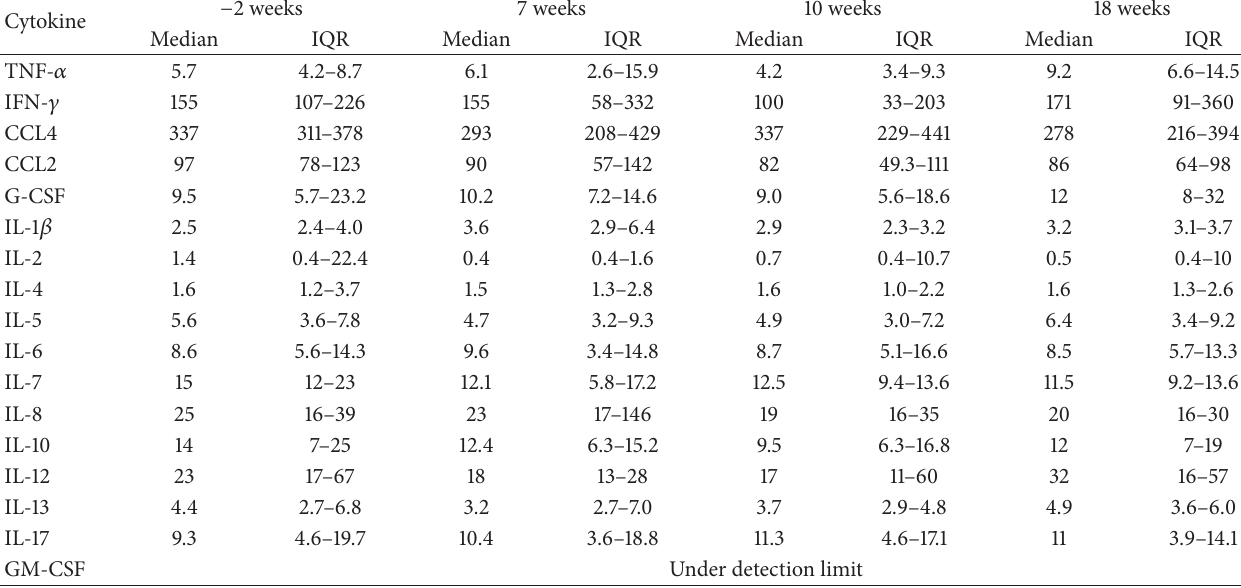
Table 2: Level of serum cytokines and chemokines (pg/mL) in MS patients at baseline and follow-up period.